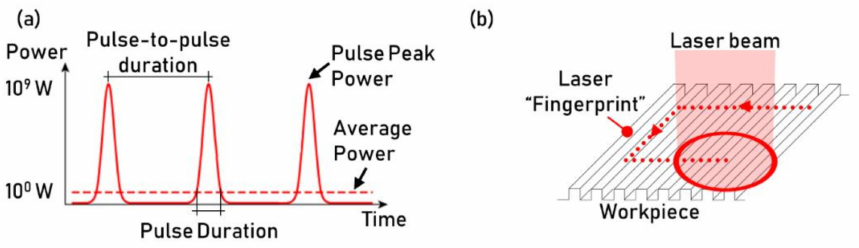
Figure 9. ( a ) Pulsing power typical shape and ( b ) the representation of the ultrafast texturing